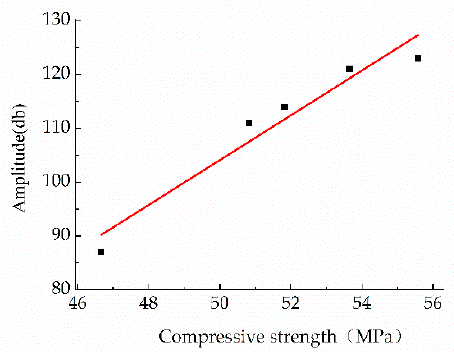
Figure 17. The fitting curve between the intensity and amplitude.